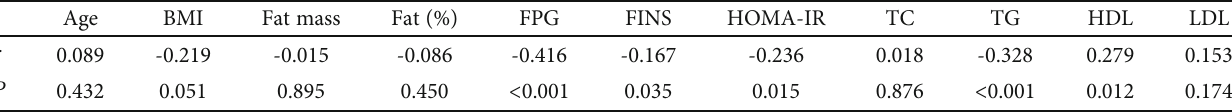
Table 2: Correlation between serum ZAG and related indexes in the case